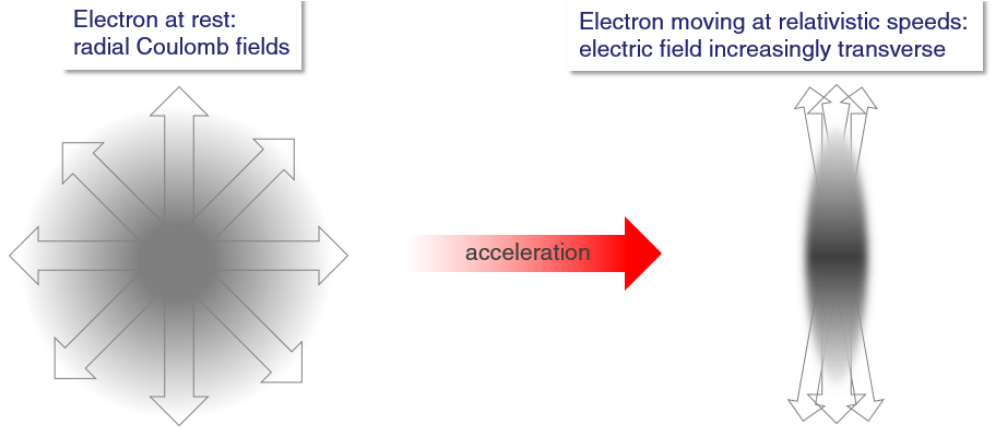
Figure 3. The electric field of a point charge in the lab frame is mainly transverse, scaling with its Lorentz factor γ